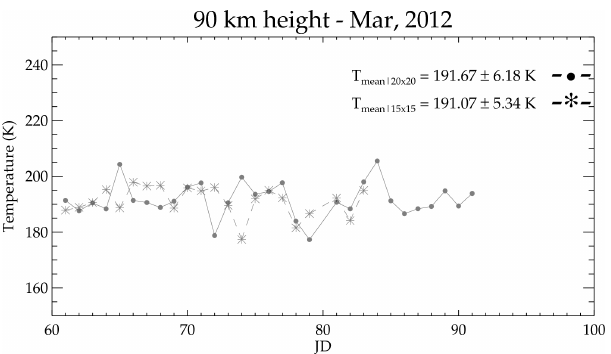
Figure 2. Daily mean temperature evolution at 90km height as de- rived from SABER/TIMED profiles during March 2012 comparing both 20 ◦ × 20 ◦ ( • ) and 15 ◦ × 15 ◦ ( ∗ ) lat/long grids.